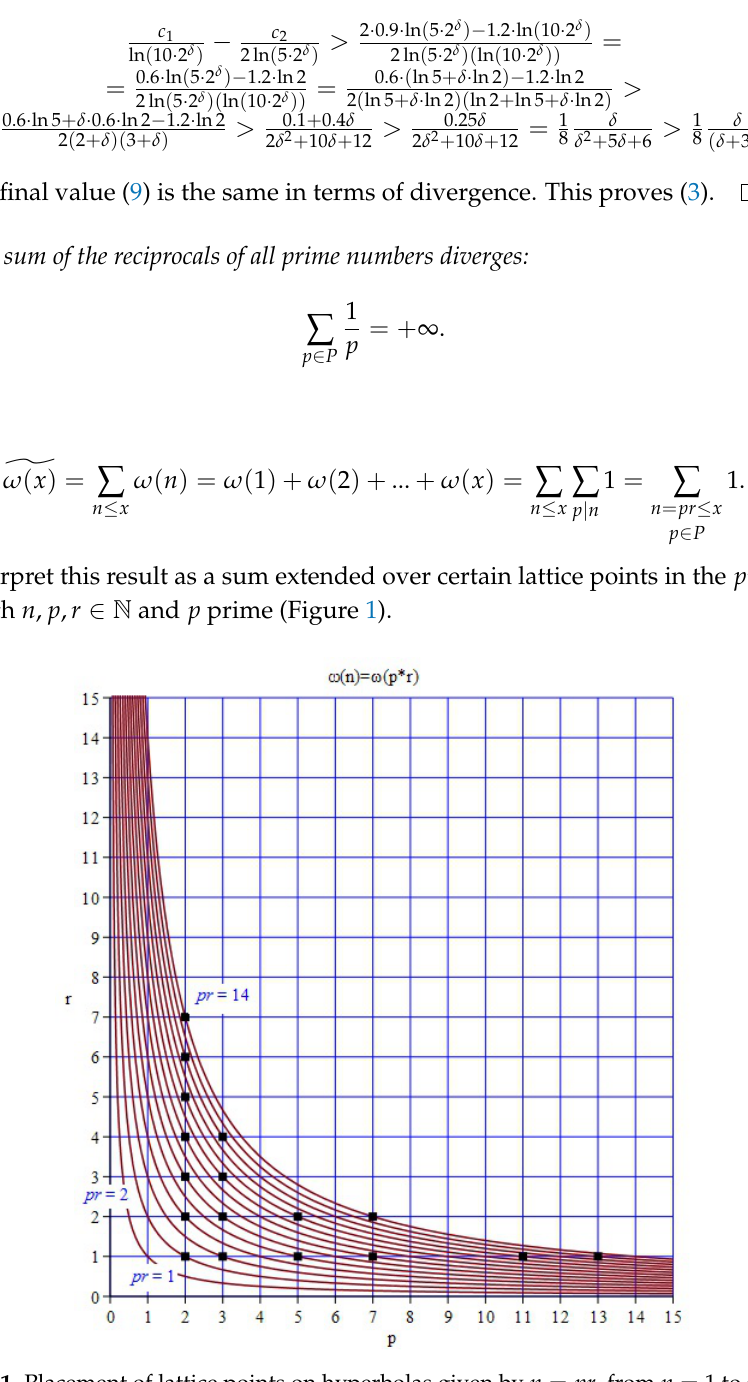
Figure 1. Placement of lattice points on hyperbolas given by n = pr , from n = 1 to n =